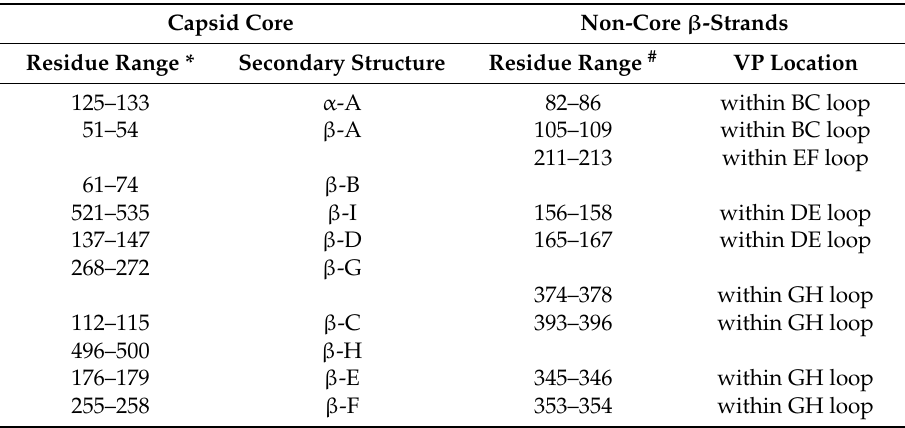
Table 2. Secondary Structure Assignments for LuIII